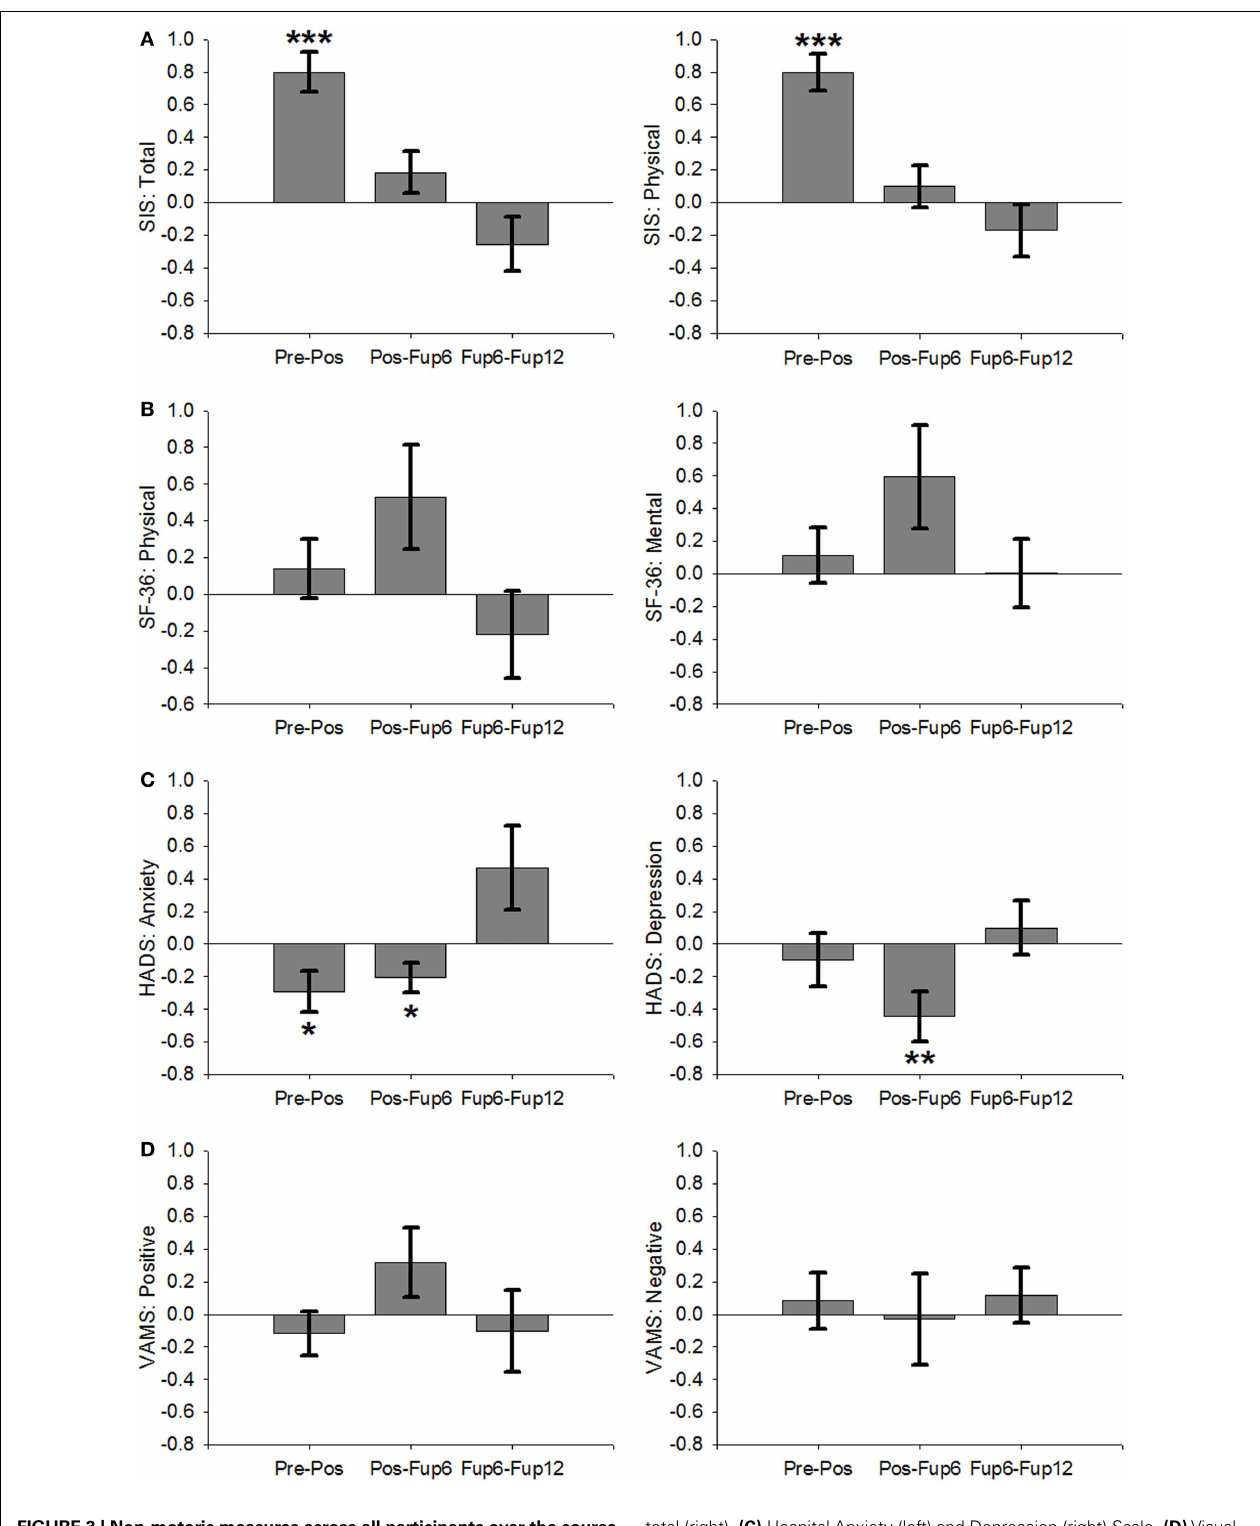
FIGURE 3 | Non-motoric measures across all participants over the course of therapy and follow-up period . (A) Stroke Impact Scale: total (left) and physical subscale (right). (B) Short Form 36: physical total (left) and mental